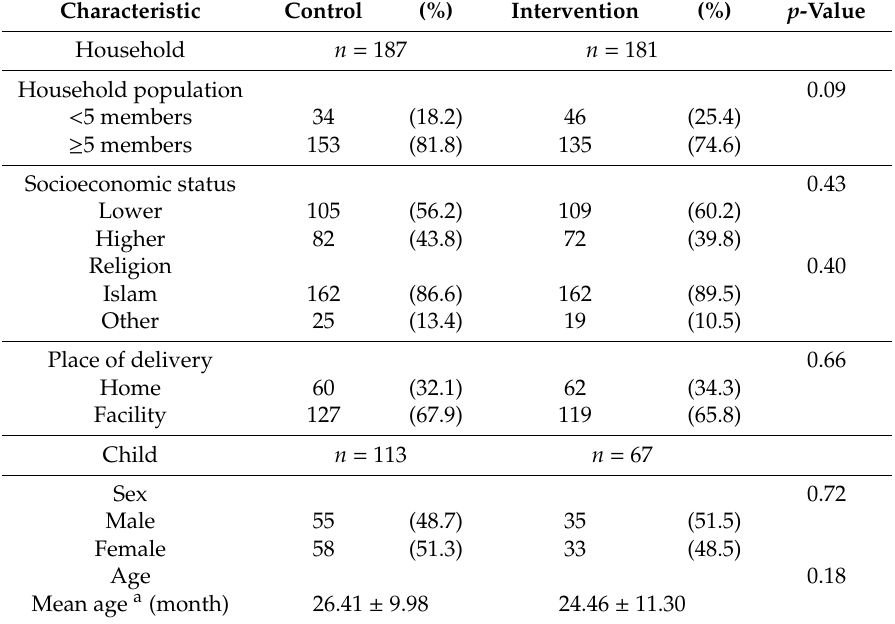
Table 1. Baseline characteristics in the control and intervention